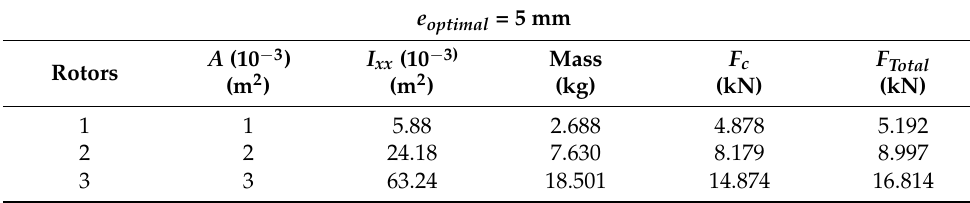
Table 7. Total forces acting on the composite blade for three rotors.